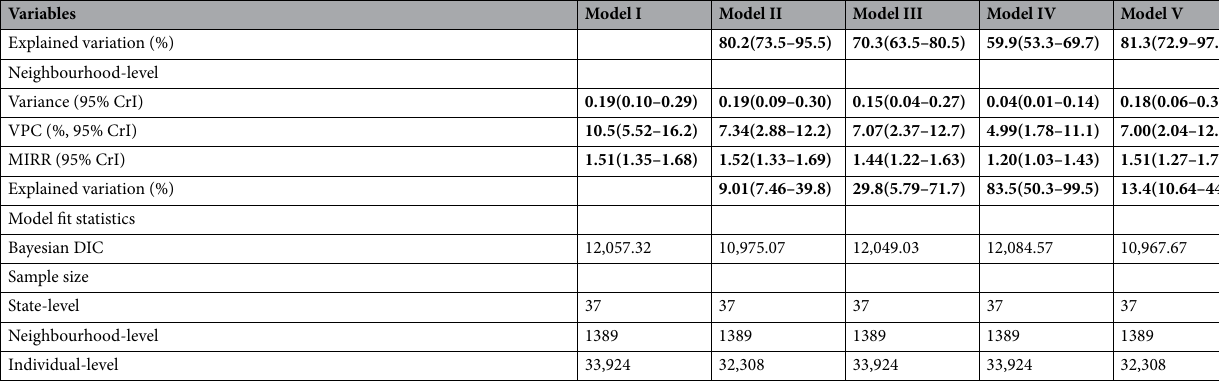
Table 3. Individual compositional and contextual factors associated with infant mortality rate identified by multivariable Bayesian multilevel Poisson regression models. IRR Incidence Rate Ratio; CrI credible interval,